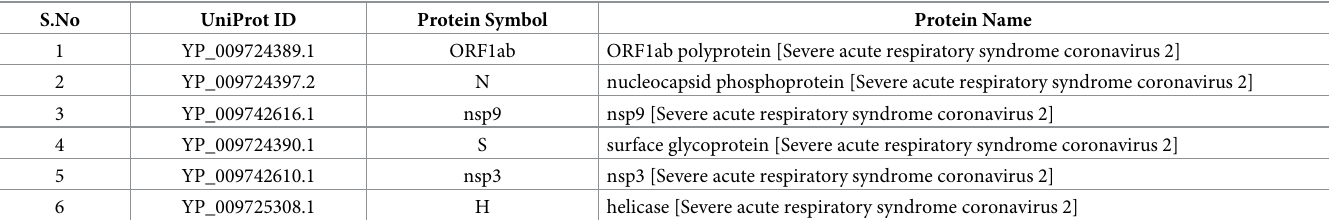
Table 1. List of viral proteins which were found expressed in the COVID infected NOPS samples. S.No UniProt